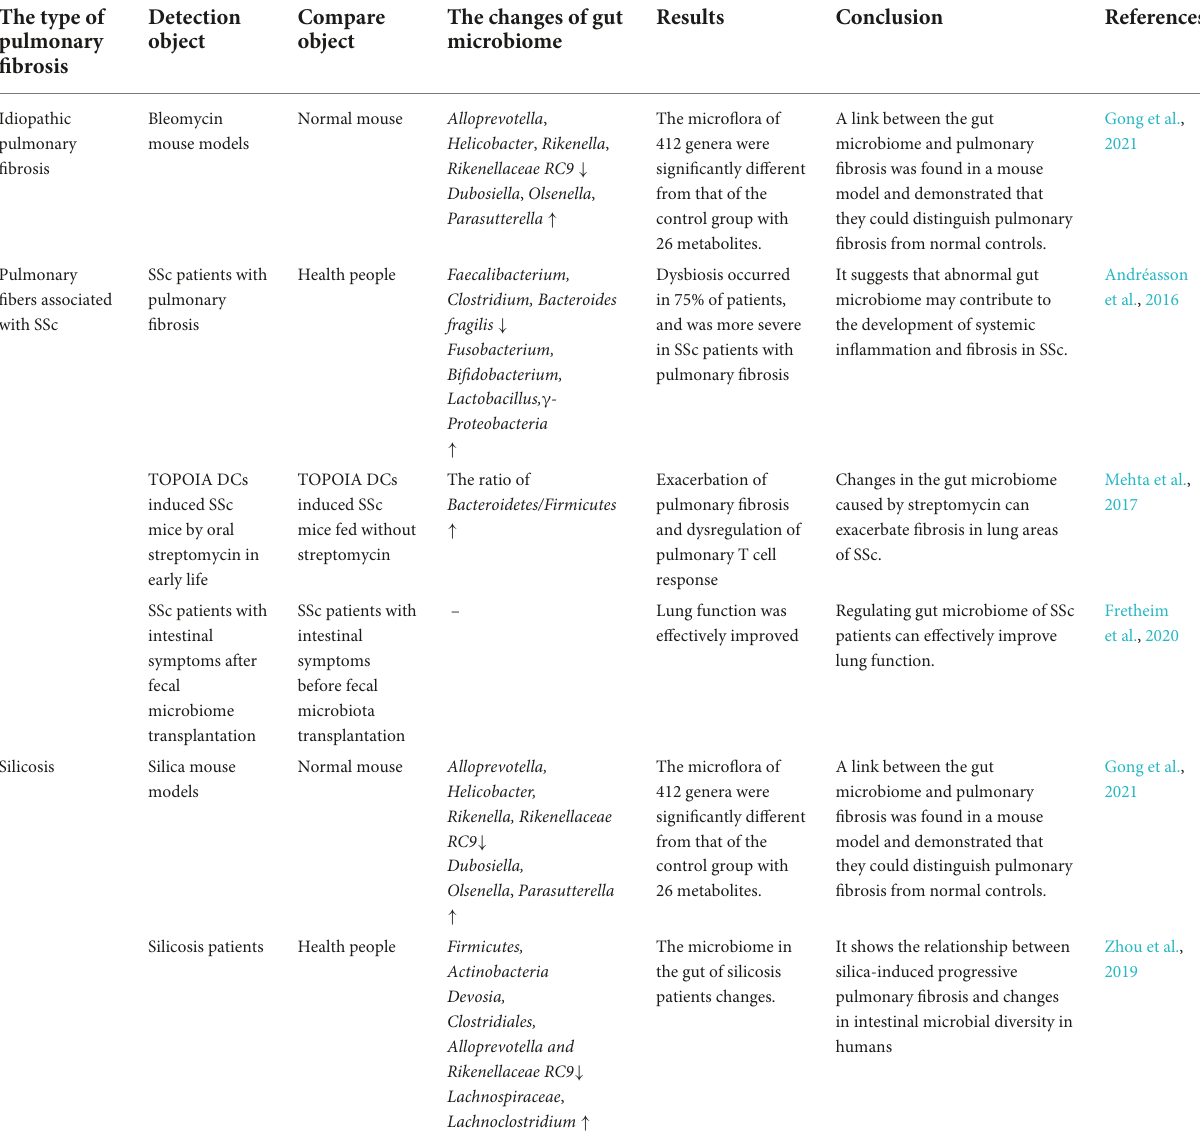
TABLE 1 Intestinal microflora detection experiment of pulmonary